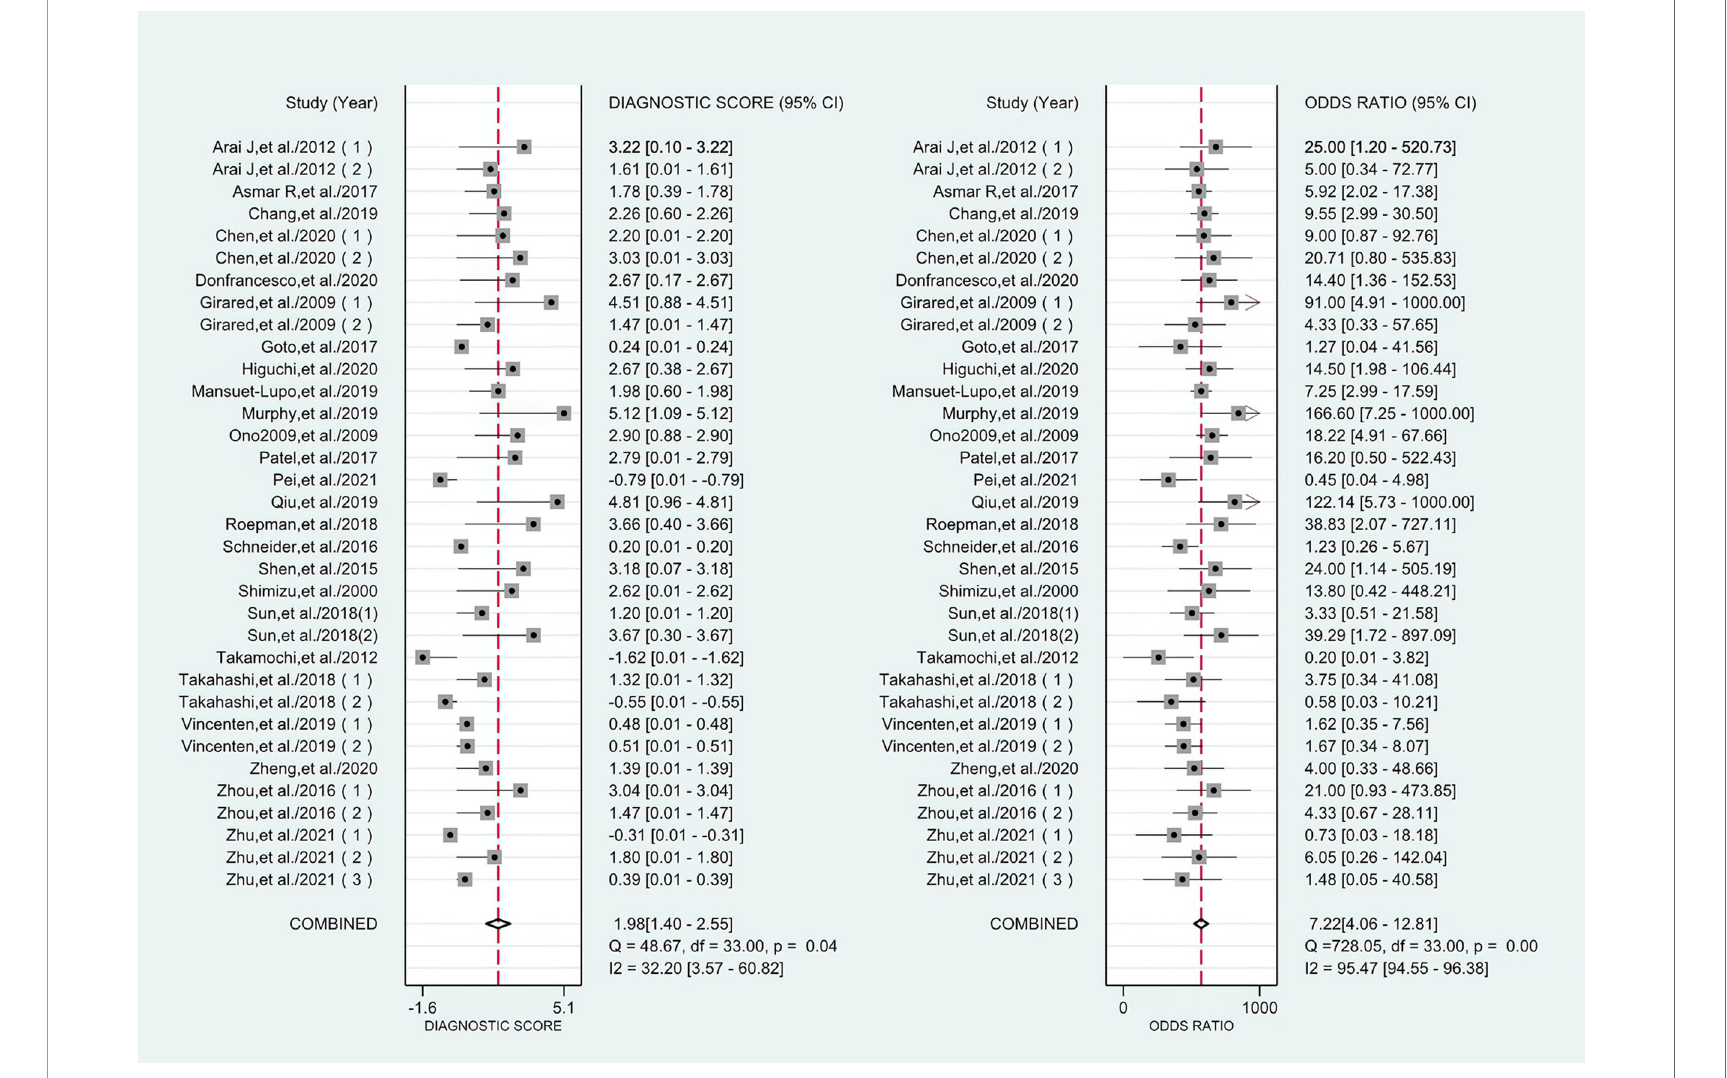
FIGURE 7 | Forest plots of the diagnostic score and DOR for histology in the differential diagnosis of MPLC and